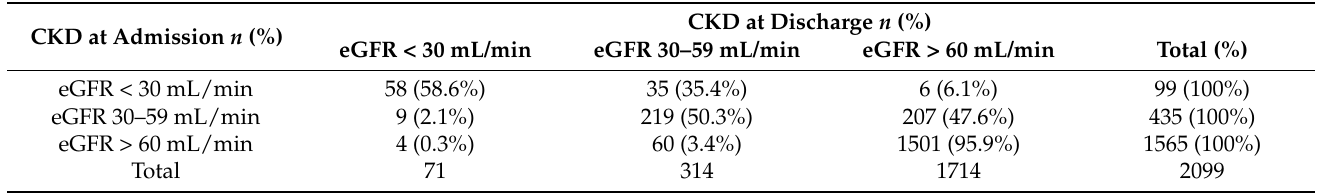
CKD at Discharge n